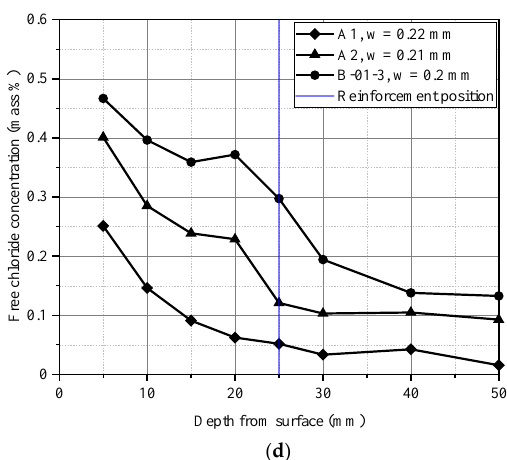
Figure 10. Free chloride profile for beam specimen series A and B after 182 days. ( a ) Beam specimen A1 ( W/C = 0.3); ( b ) Beam specimen A2 ( W/C = 0.35); ( c ) Beam specimen series B-01 ( W/C = 0.4); ( d ) Comparison among specimens under different water – cement ratio.